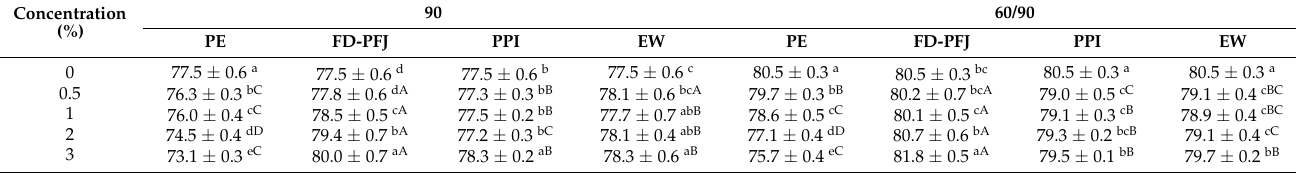
Table 5. Effect of inhibitors on the whiteness of PW surimi gels with four different inhibitors (PE, FD-PFJ, PPI, and EW) at 0, 0.5, 1, 2, and 3% levels heated to 90 ◦ C directly (90) and held at 60 ◦ C for 30 min prior to heating to 90 ◦ C